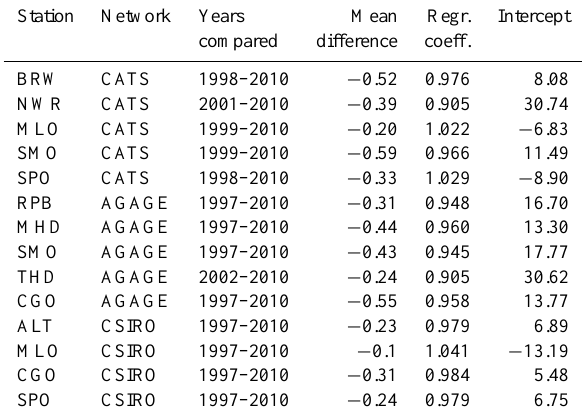
Table 2. Comparison of different networks with NOAA CCGG at sites with parallel measurements. The mean difference is calculated as NOAA CCGG minus other (units of nmolmol − 1 ) . The regres- sion coefficient (slope) and intercept are given for a linear regres- sion of the other network vs. NOAA